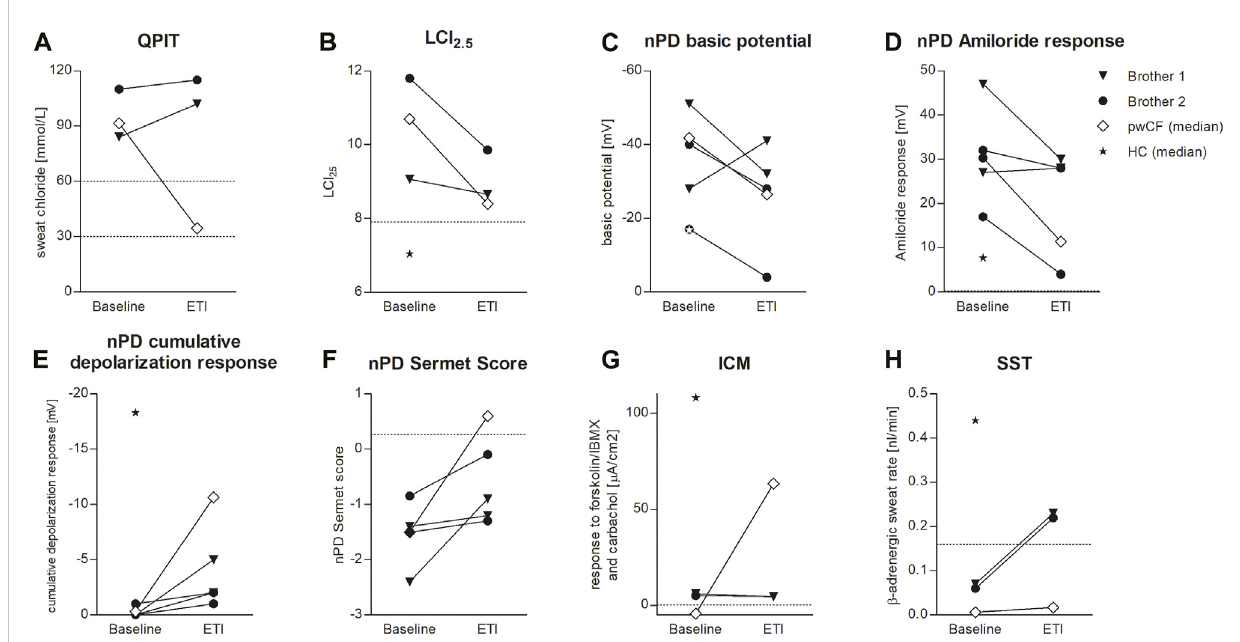
FIGURE 1 Effects of ETI on QPIT (A) , LCI 2.5 (B) , nPD basic potential (C) , nPD Amiloride response (D) , nPD cumulative depolarization response to chloride-free solutionandisoproterenol (E) ,nPDSermetScore (F) ,responsetoforskolin/IBMXandcarbacholinICM (G) andSST (H) inbrother1(triangle)andbrother2 (circle) compared to the median effect on pwCF with one or two p.Phe508del alleles (white square) and reference values for healthy controls (HC, star).